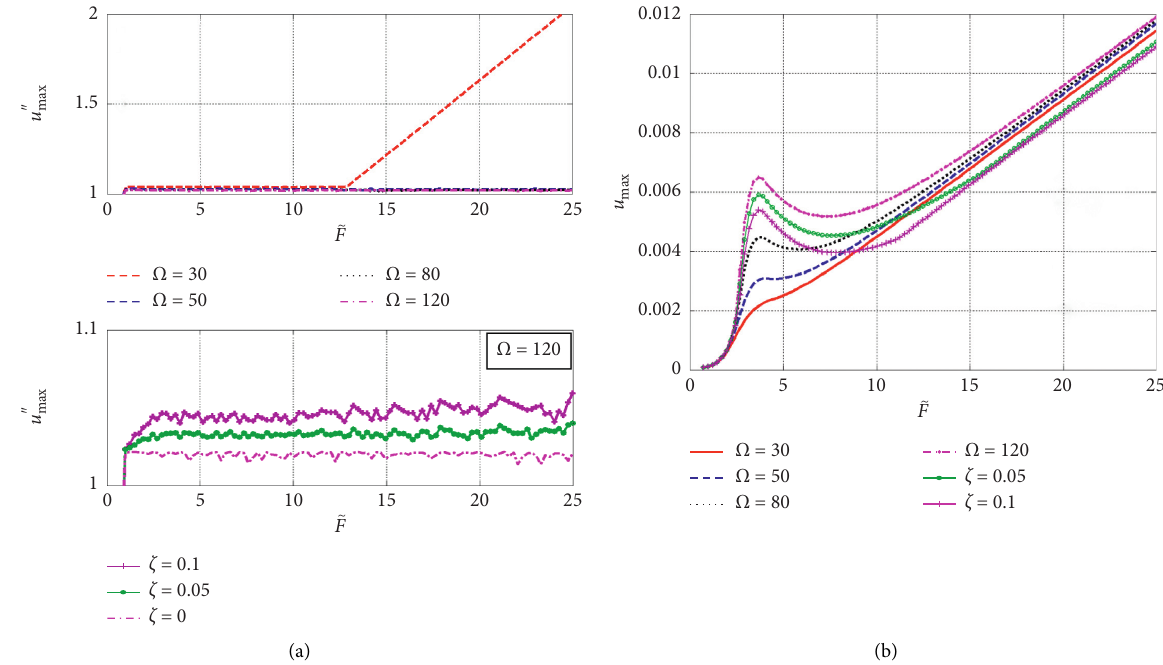
Figure 9: The dimensionless resilient force-displacement curves of the NSA ( ζ � 0, 􏽥 A � 1, w � 200 π /s, μ � 6 . 7 × 10 − 4